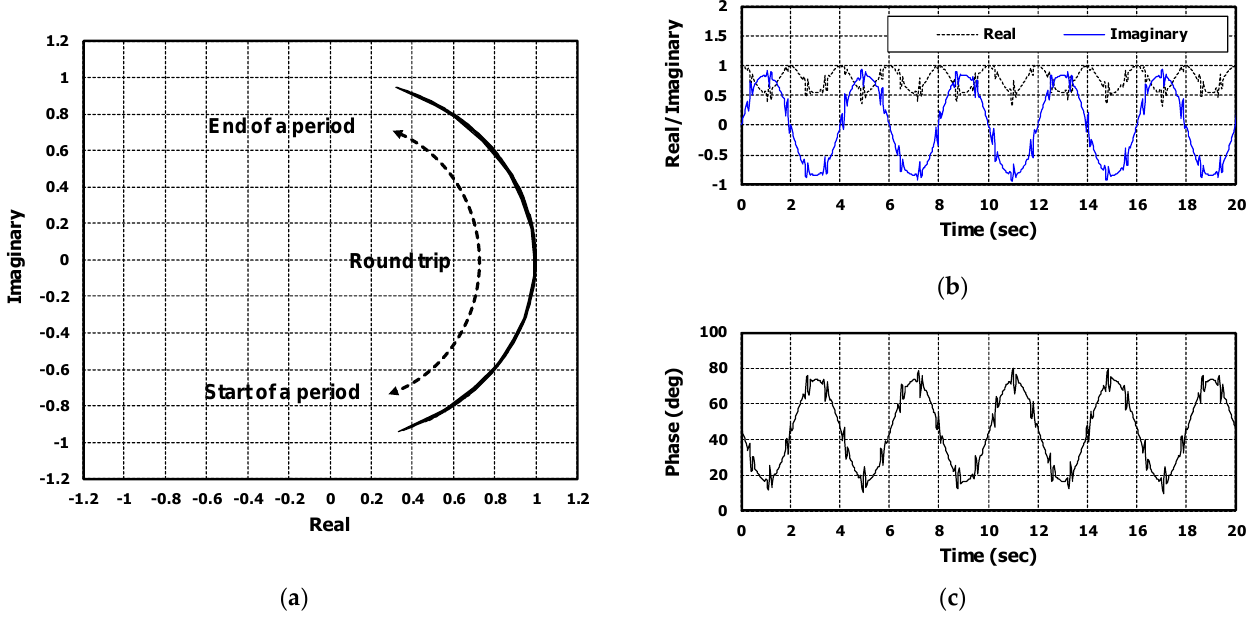
Figure 5. The signals simulated by proposed radar IF signal model including respiration and heartbeat signal. The signals were shown in ( a ) IQ domain and ( b ) time domain. ( c ) is the extracted phase from real and imaginary signals.